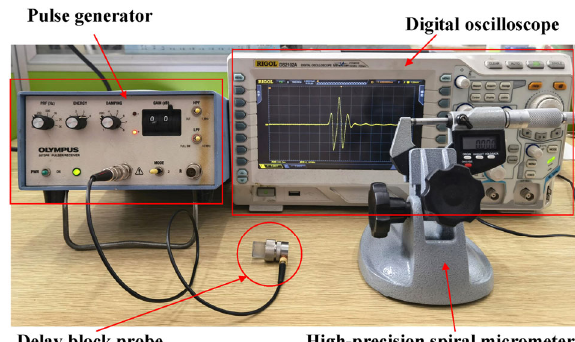
Fig. 20 Vertical bearing test